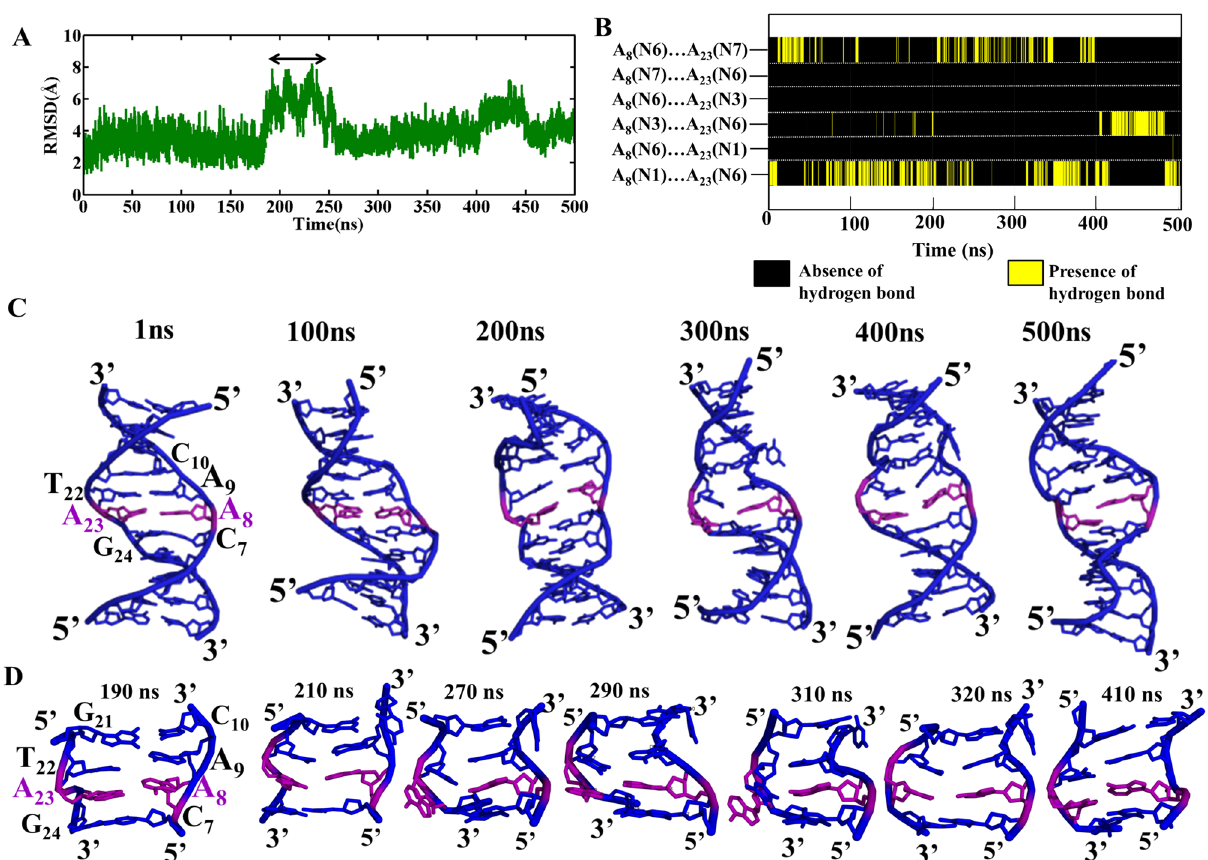
Figure 3. Analysis of DCA-1 DNA duplex that has anti … + syn starting glycosyl conformation for A 8 …A 23 . ( A ) Time vs RMSD profile. The double headed arrow indicates the increase in the RMSD during 190–250 ns. The MATLAB 7.11.0 software (www.mathw orks.com) was used to plot the data. ( B ) Life time (X-axis) of different A 8 …A 23 hydrogen bond schemes (Y-axis). The GNUPLOT 5.2 software was used to plot the data 54 . ( C ) Snapshots showing the local B–Z junction formation at the mismatch site. ( D ) The local conformational dynamics associated with the increase in RMSD ( A ). Note: A 8 …A 23 mismatch is represented in purple color in the cartoon representation. The figures ( C ) and ( D ) were generated by using Pymol 1.3 (www.pymol .com) software 53